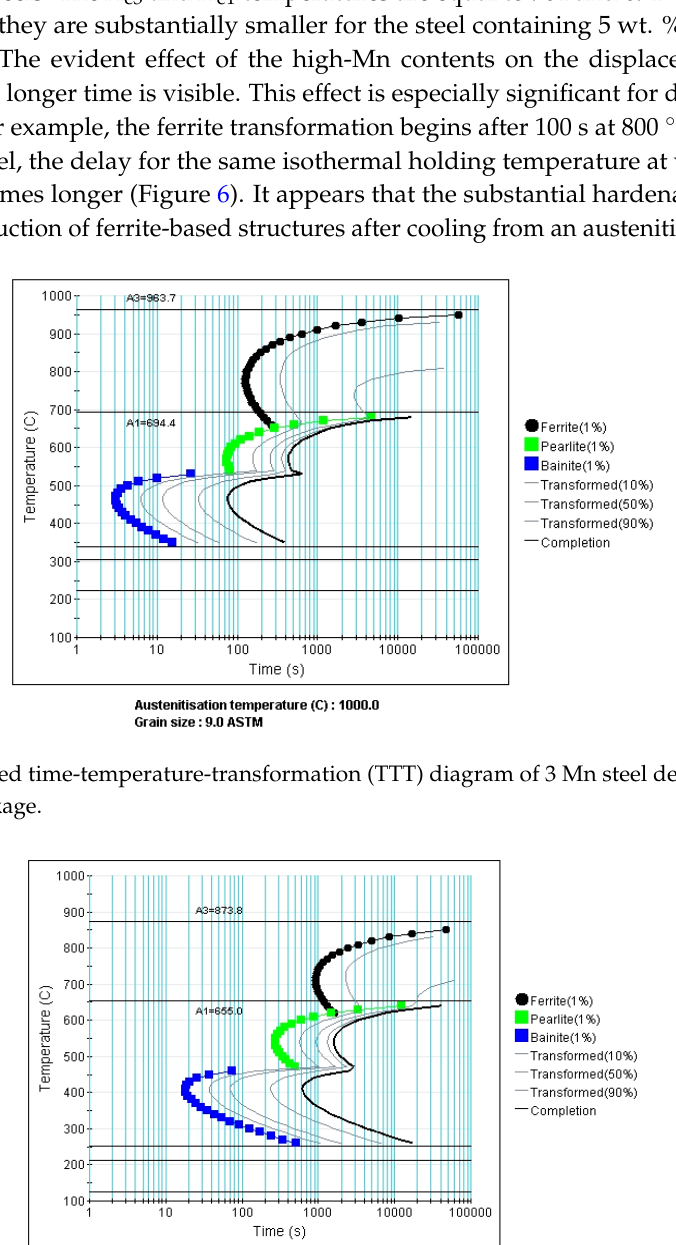
Figure 6. Predicted TTT diagram of 5 Mn steel determined using the JMatPro package.